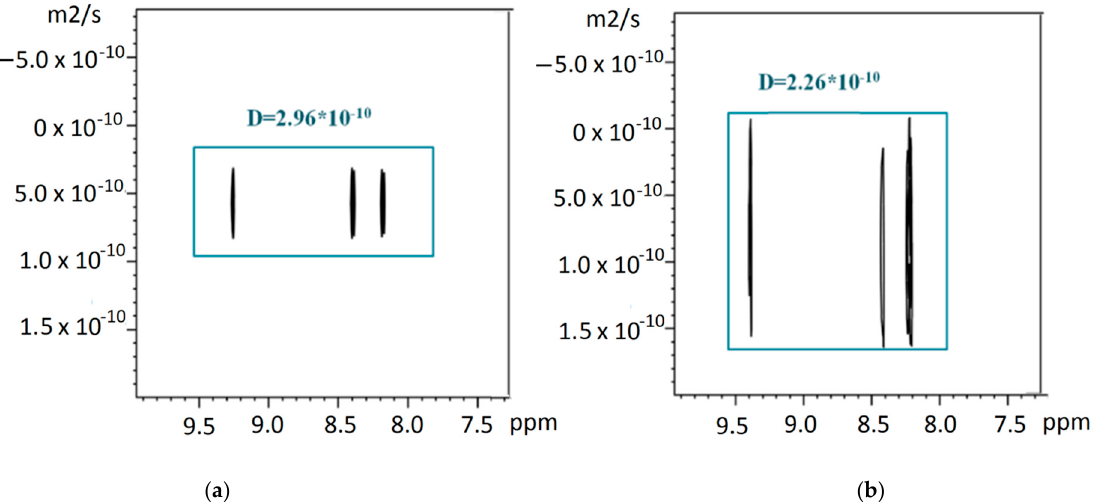
Figure 10. 1 H NMR diffusion-ordered spectroscopy (DOSY) spectra of products of interaction the complex I ( a ) and porphyrin dimers with Cu 2+ I-Cu-I( b ).